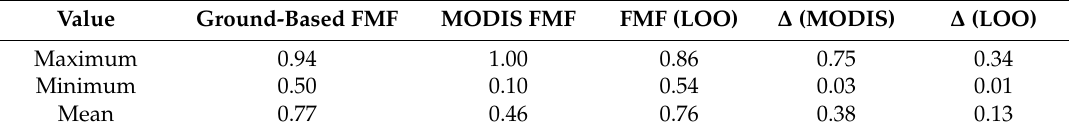
Table 3. Comparison between the pre-fusion and leave-one-out validation results of Winter 2015 at ground-based locations a